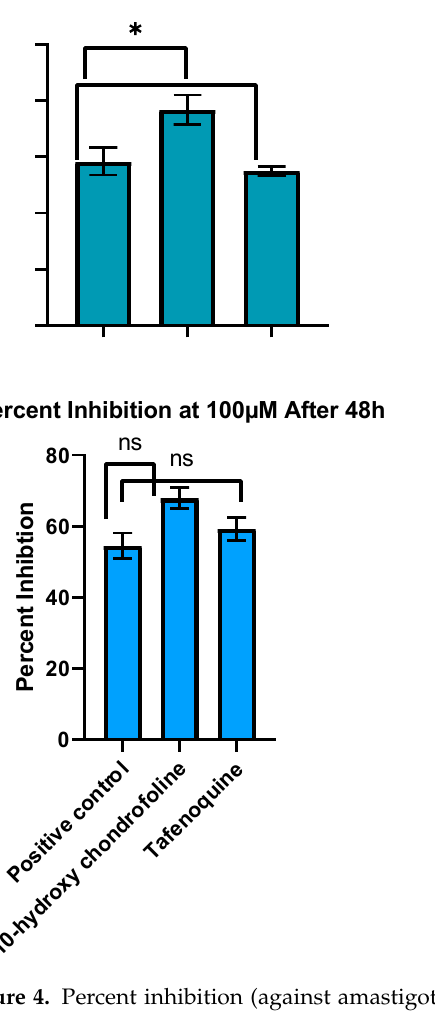
B A C Figure 5. Representative images of the difference between the size of cutaneous lesions of the infected footpad after 20 days of ( A ) Negative control (Placebo) ( B ) 10-hydroxy chondrofoline ( C ) Positive control (meglumine antimoniate).